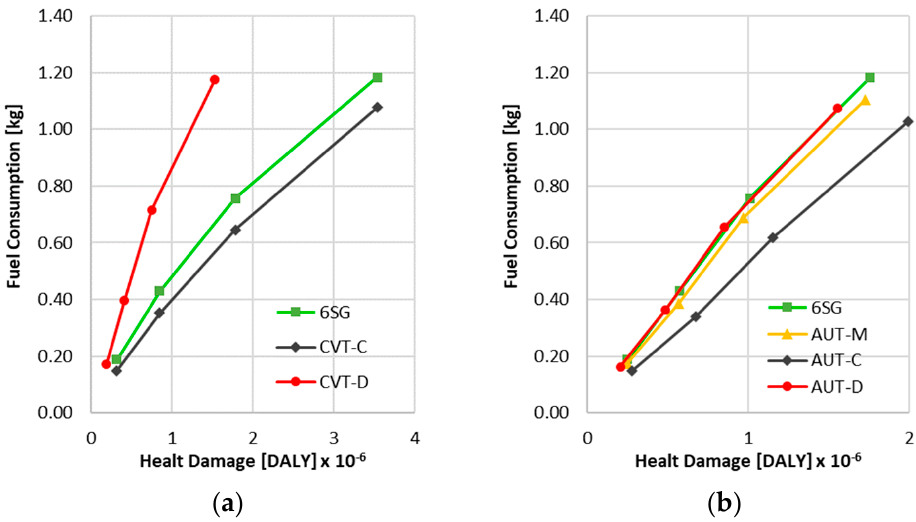
Figure 7. Total cumulative damage over the WLTC cycle for CVT ( a ) and AUT ( b ) and 6SG powertrains. The dots refer to the end of the four phases of the WLTC cycle.